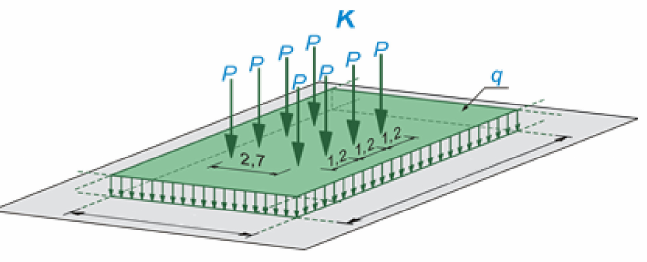
Figure 8. Traffic loads class C (q and K types) according to standard PN-S-10030